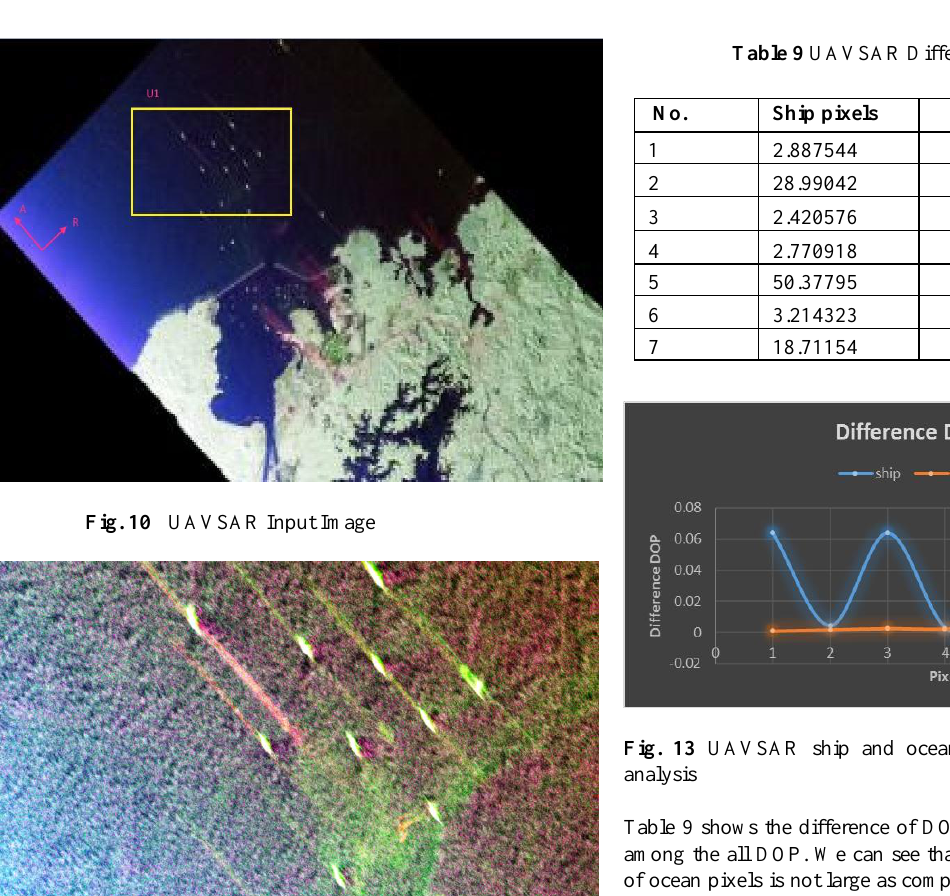
Fig. 11 UAVSAR Sub image U1 (792 * 1583)